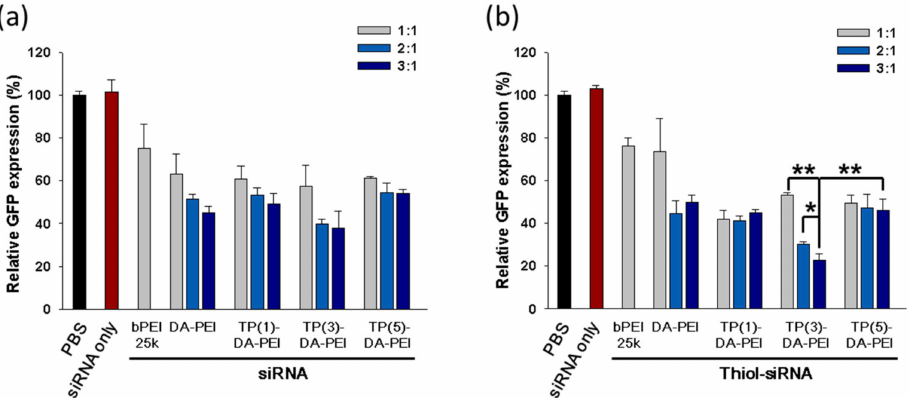
Figure 3. Green fluorescence protein (GFP) gene silencing efficiency of bPEI25k, DA-PEI, TP(1)-DA-PEI, TP(3)-DA-PEI, and TP(5)-DA-PEI condensed with ( a ) GFP siRNA and ( b ) thiol-GFP siRNA,